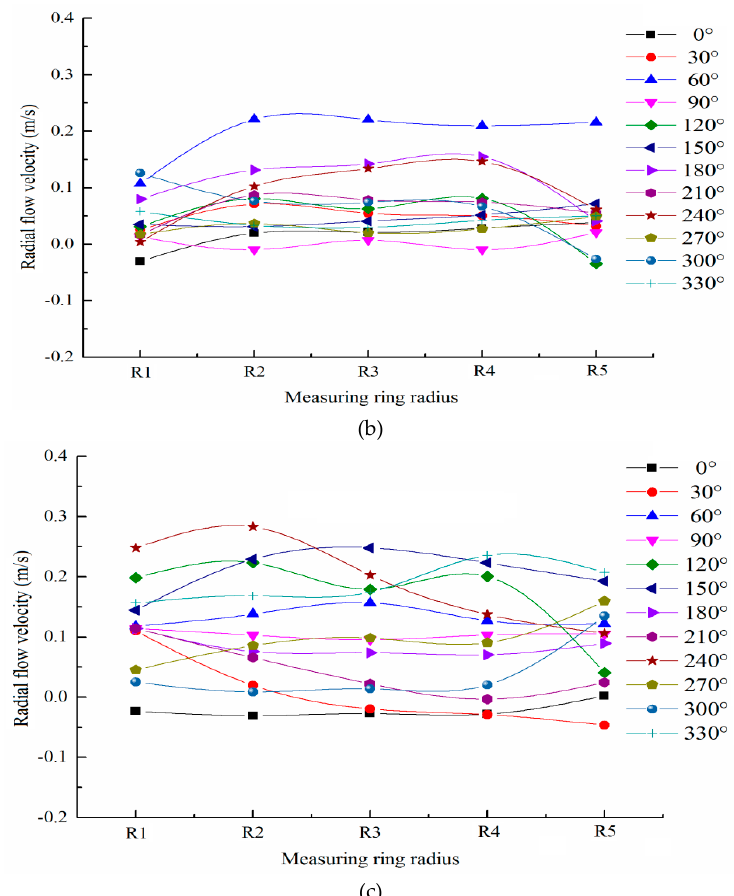
Figure 18. Radial velocity of the same polar axis: ( a ) rear section; ( b ) middle section; and ( c ) front